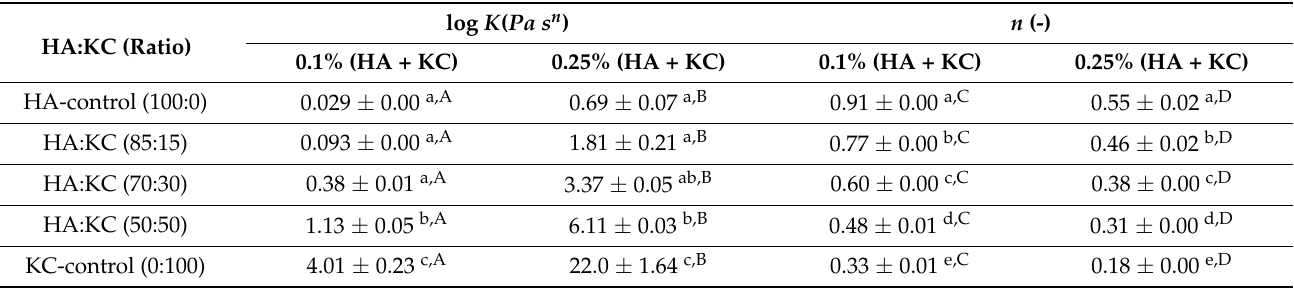
Table 1. Power law-derived consistency coefficient ( K ) and flow behavior index ( n ) of skim milk samples treated with different concentrations and ratios of HA + KC blend.